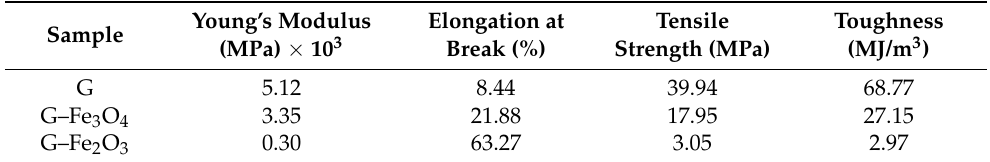
Table 2. Main mechanical properties for the studied samples.